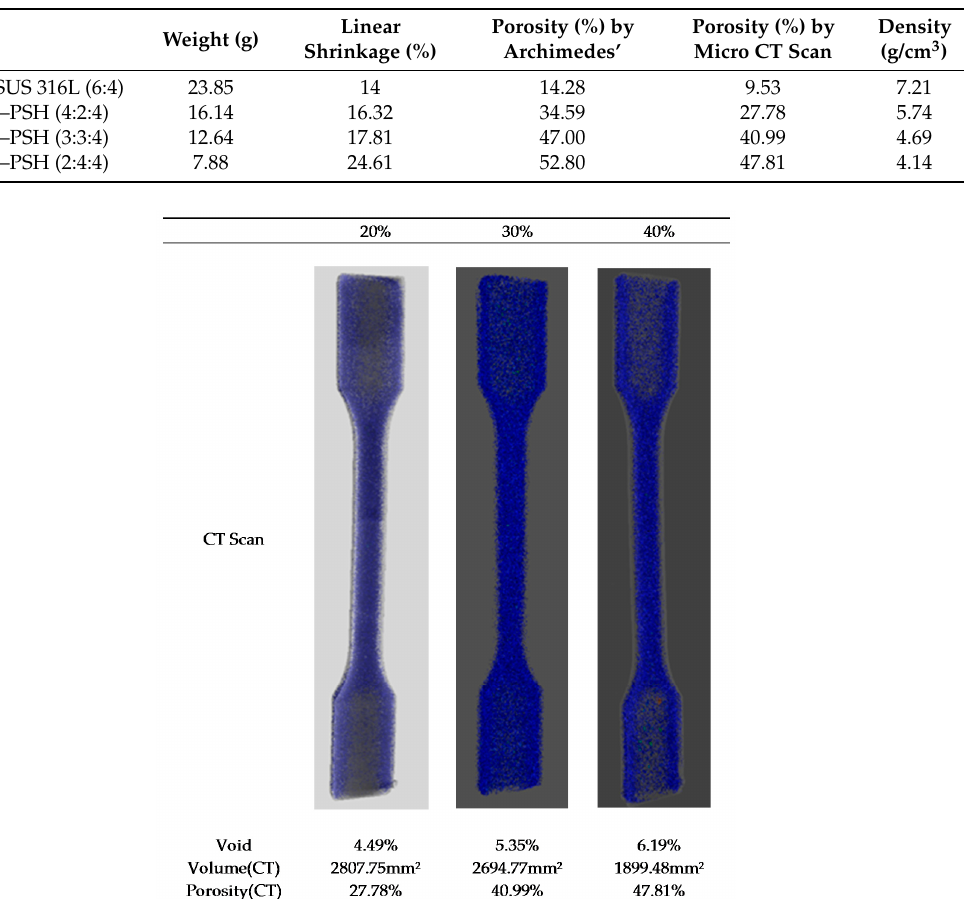
Figure 16. Micro CT scan of the tensile specimens and the porosity results for different polymethyl methacrylate (PMMA) space holder volume fractions.